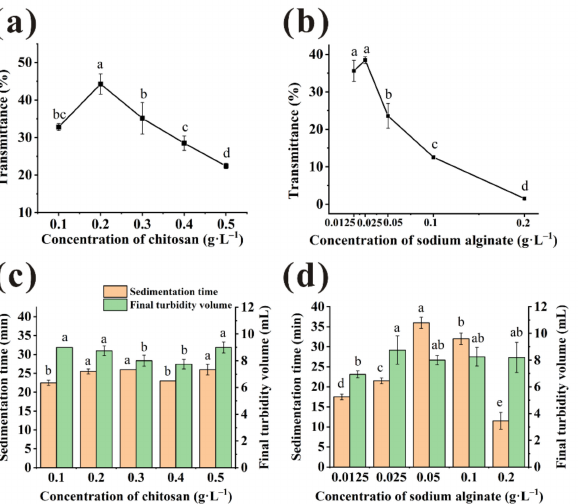
Figure 1. Transmittance of the bayberry juice clarified with chitosan (CTS) ( a ) and sodium alginate (SA) ( b ) under various concentration. Sedimentation time and final turbidity volume of the bayberry juice clarified with CTS ( c ) and SA ( d ) under various concentration. (Different little letters mean a significant difference at the level of